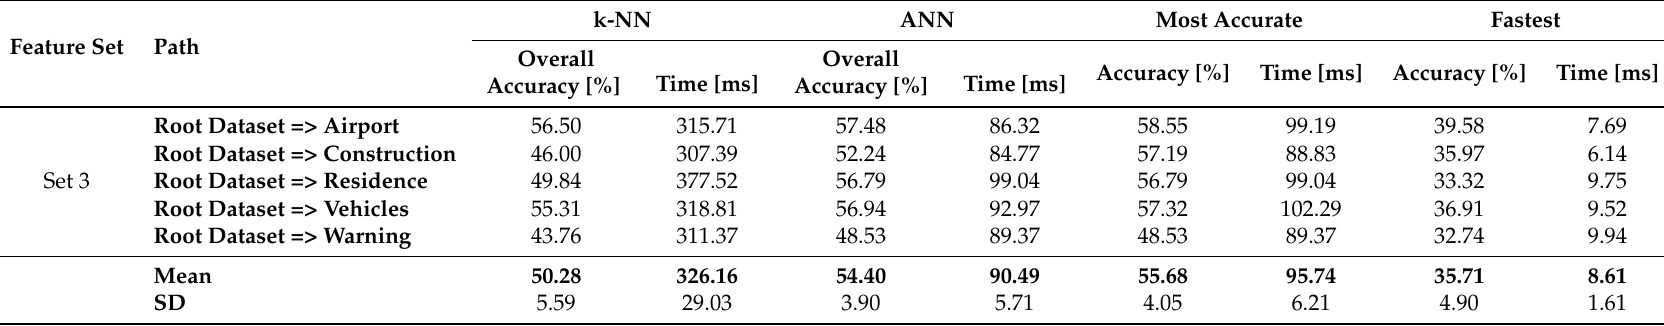
Table 16. Achievable accuracy and demanded execution time of the optimized classifiers performance using the proposed cascade approach running on the Raspberry Pi. The last row details the mean and the standard deviation (SD) of the global accuracy and timing.